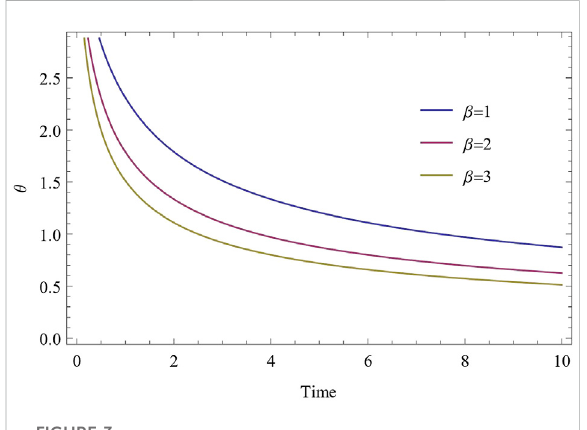
FIGURE 3 The plot of expansion scalar θ versus time t.